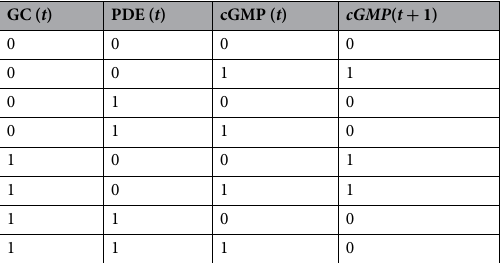
Table 3. cGMP regulatory table. The first 3 columns in this table contain all the possible activation states of the cGMP regulators (GC, PDE, cGMP); the fourth column shows the values for the function that correspond to each combination of those